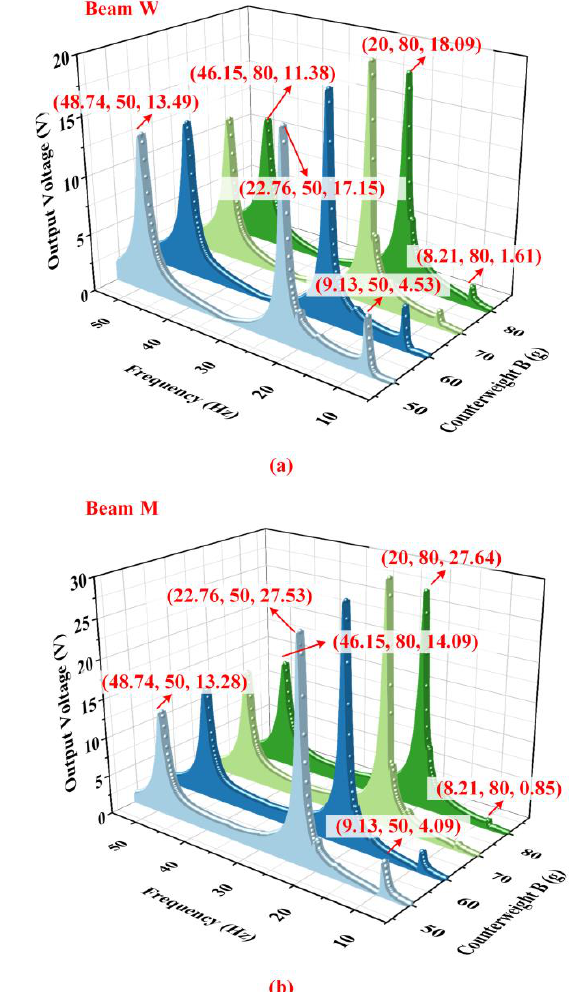
Figure 12. The output voltage of ( a ) beam W and ( b ) beam M with different weights of counterweight B.